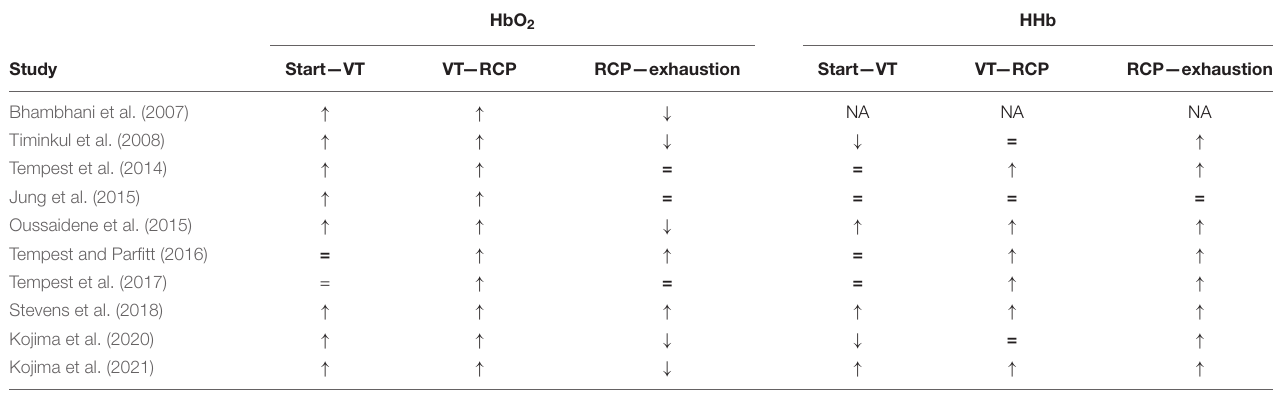
TABLE 6 | Summary of finding on the evolution of HbO 2 and HHb during MIT. HbO 2